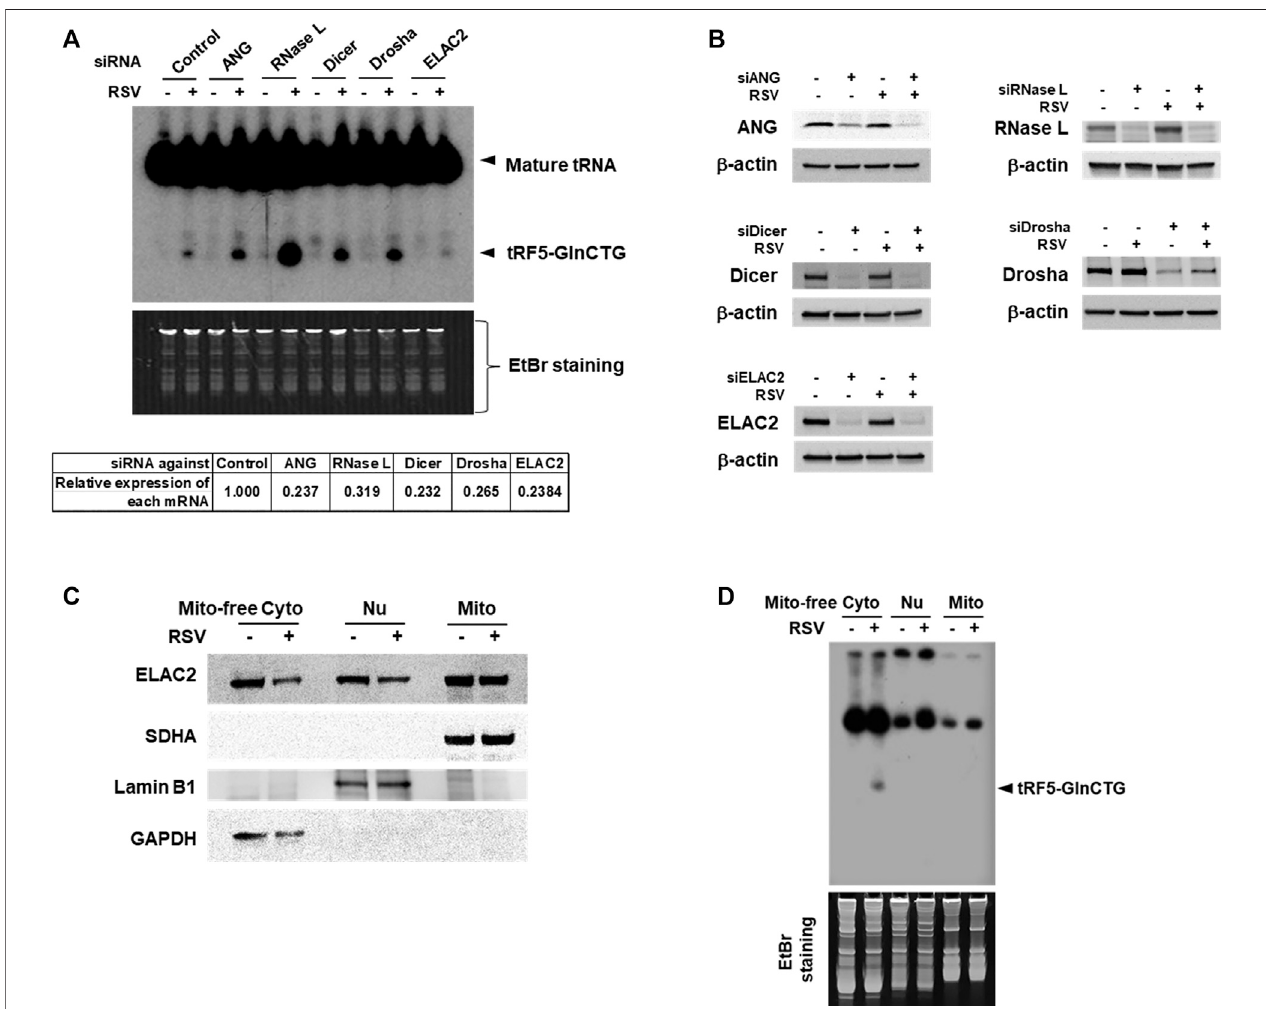
FIGURE3| ELAC2isresponsiblefortheinduction oftRF5-GlnCTG. (A) A549cellsweretransfectedwith100nmol/lofsiRNA againstindividualindicatednuclease or control siRNA. At 40 h post-transfection, the cells were mock- or RSV-infected at an MOI of 1 for 24 h, followed by Cyto RNA preparation and Northern hybridization for the detection of tRF5-GlnCTG. The individual gene knockdown was veri fi ed by qRT-PCR (down panel). (B) Cells were transfected with siRNAs and then mock- or RSV-infected as described in (A) , followed by total protein preparation and then Western blot using antibodies against individual targets. β -actin was used as a loading control. (C) Compartmental locations of ELAC2. Cells were uninfected or infected with RSV at an MOI of 1 for 24 h, followed by subcellular fractionation preparation for mitochondria-free cytoplasm (Mito-free Cyto), nuclei (Nu), and mitochondria (Mito) and then Western blot using the indicated antibodies. The purity of fractions was assessed by compartment-speci fi c proteins. The succinate dehydrogenase complex subunit A (SDHA), Lamin B1, and Glyceraldehyde 3-phosphate dehydrogenase (GAPDH) serve as a mitochondrial, nuclear, and mitochondria-free cytoplasmic marker, respectively. Data are representative of 2-3 independent experiments. (D) RNAwaspreparedfromsubcellularfractionatedcompartmentsasdescribedin (C) .Thesameamountof10µginallfractionatedRNAswasloadedtoa denaturing polyacrylamide gel for Northern hybridization to detect tRF5-GlnCTG. The loading ratio of each fraction was: all Mito RNAs vs 1/25 for Nu RNA vs 1/100 for Mito-free Cyto RNA. Data are representative of 2-3 independent